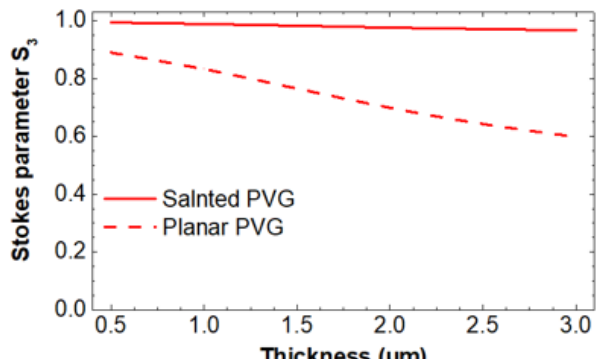
Figure 5. Stokes parameters S3 as a function of film thickness. The horizontal period ( P x ) is 440 nm, vertical period ( P z ) is 205 nm, central wavelength is 532 nm and Δ n is 0.15.